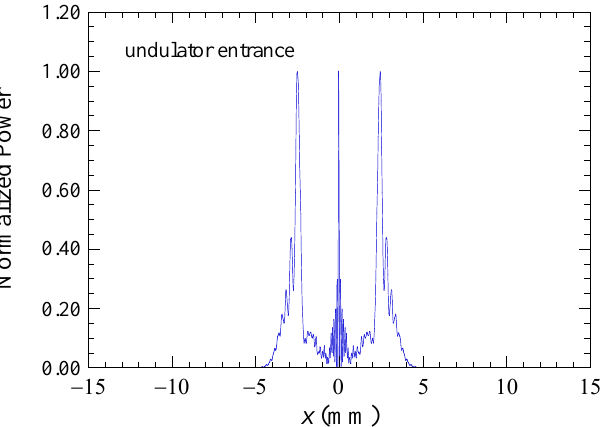
Figure 17. Cross-section of the optical field at the undulator entrance on pass 60 for a cavity detuning ∆ L cav = − 18 λ and an undulator field strength of B u = 6.658 kG ( K rms = 1.055). The other parameters are given in Table